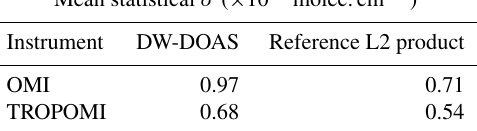
Table 4. Comparison of mean SCD statistical uncertainties for OMI QA4ECV, TROPOMI, and DW-DOAS, calculated from SCDs from a remote area in the Pacific Ocean within latitudes [60 ◦ S, 60 ◦ N] and longitudes [180 ◦ W, 150 ◦